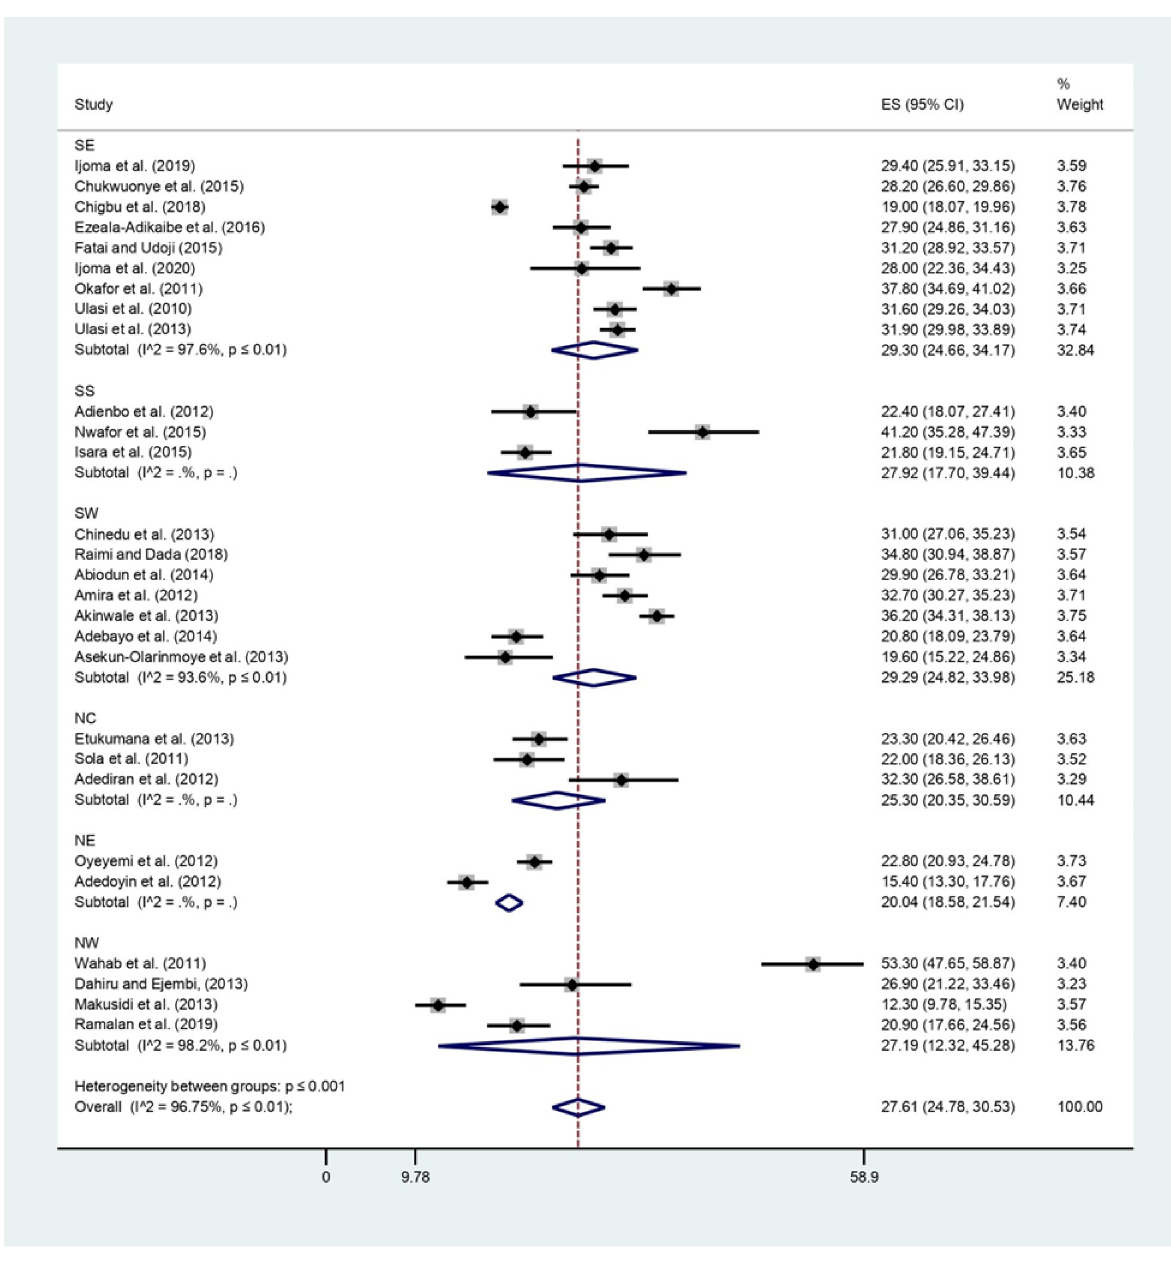
Fig 3. The prevalence of overweight in the six geopolitical zones in